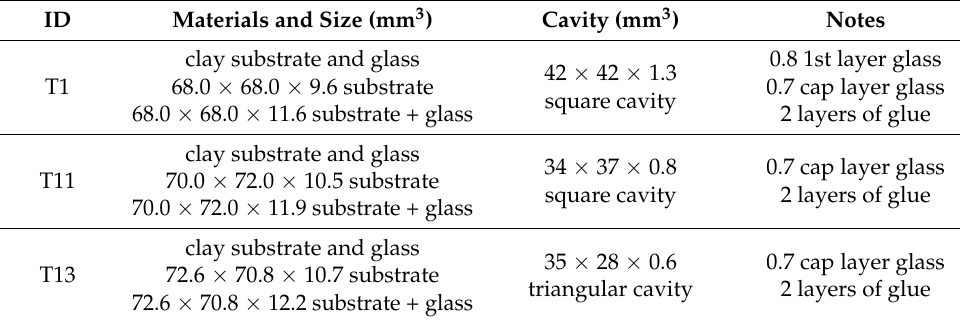
Table 2. List and details of the tile models under study.